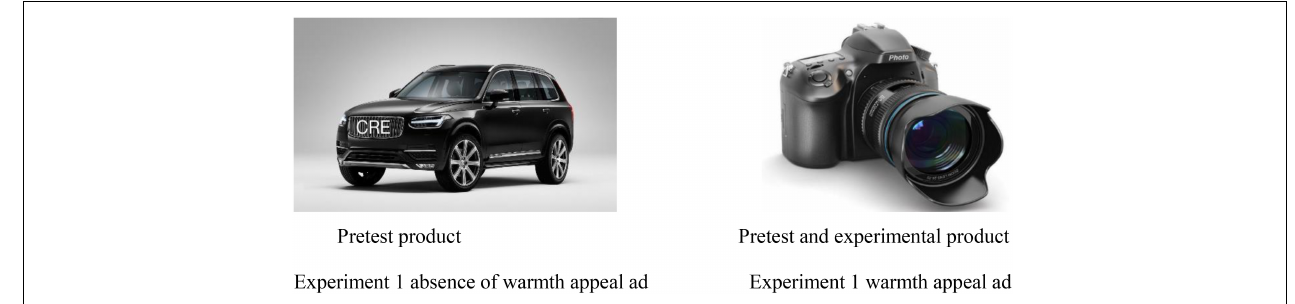
FIGURE 2 | Pictures of the experimental materials in Experiments 1 and 2. Reproduced with permission from carsales and Saint-Louis Studio (image sources, car: https://www.carsales.com.au/volvo/xc90/price/2019/; camera: